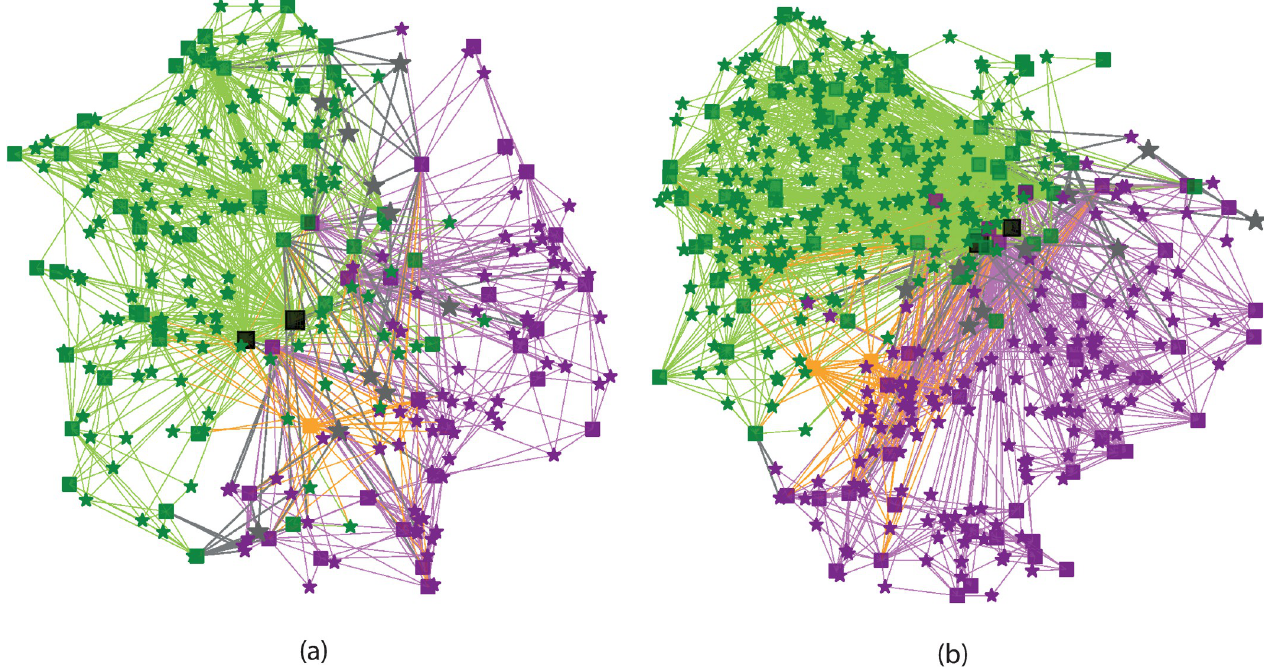
Fig 1. Visual representation of the bipartite network of (a) T . thermophilus from Bacteria [16] and (b) S . cerevisiae [17] from Eukarya. The squares represent ribosomal elements and stars the interactions. Green indicates elements and interactions in the LSU, where the peptide bond formation occurs. Magenta indicates elements and interactions in the SSU, where decoding takes place. Grey indicates inter-subunit bridges and orange indicates tRNAs. To emphasize domains 2 and 5 of 23(25)S rRNA, they are plotted respectively in black with the former twice as large as the other nodes to indicate its dominant centrality and the latter 50% larger. The positions of each node were obtained from the structural file by calculating the center of mass coordinates of the residues involved in the node. The three-dimensional coordinates were then projected into two-dimensions.